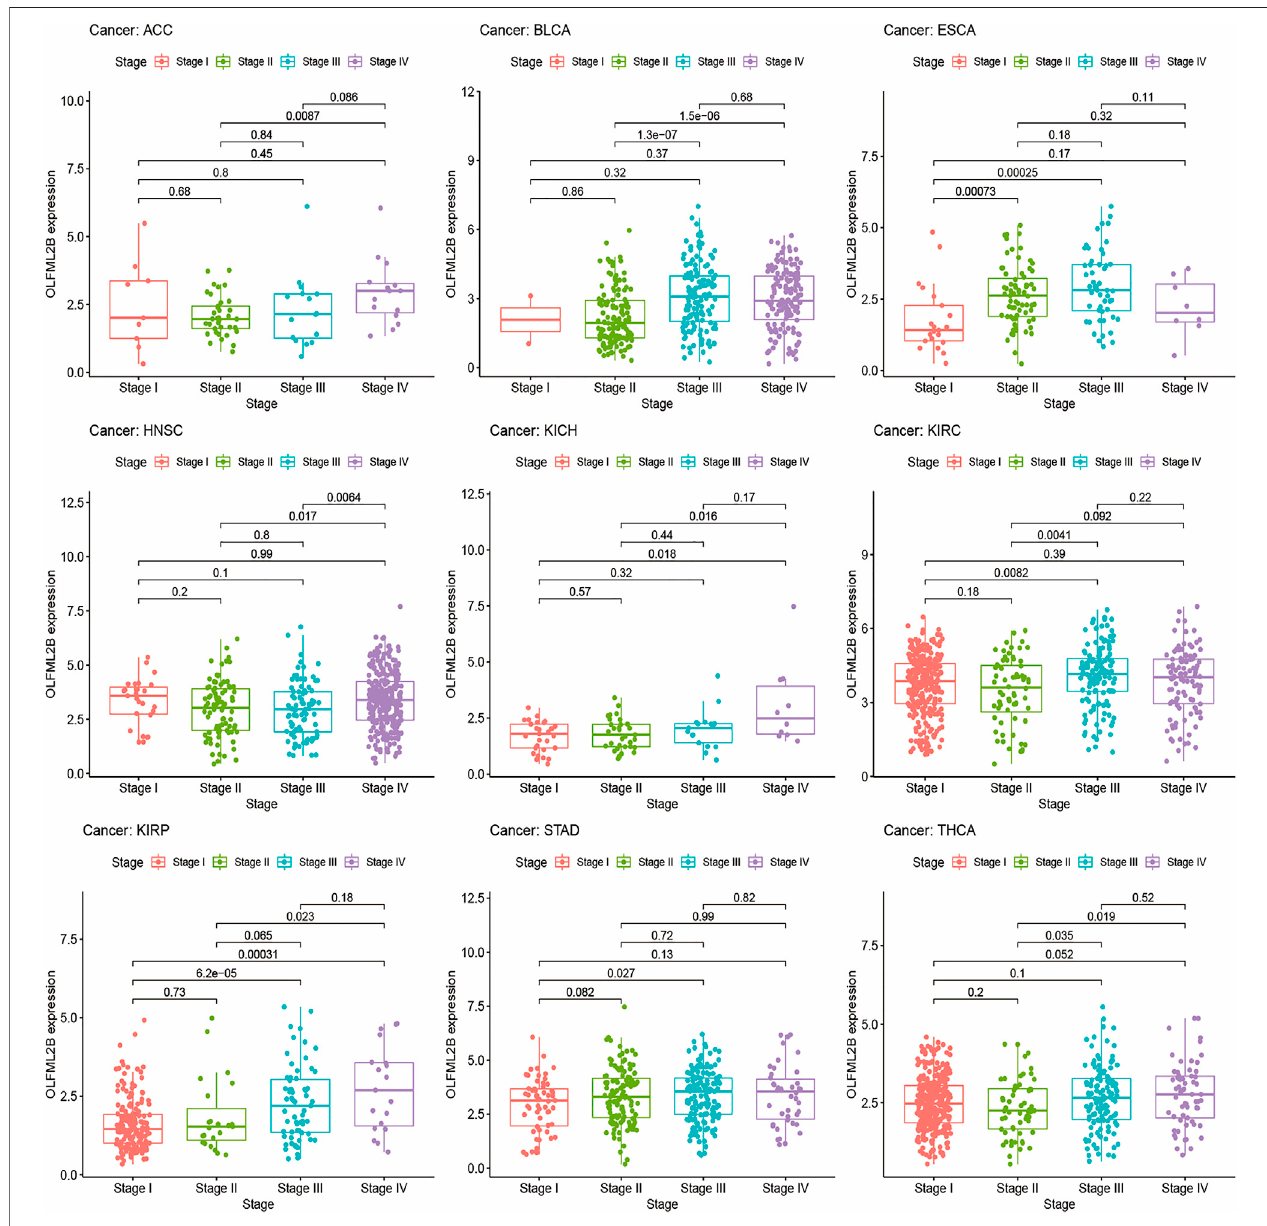
FIGURE 4 | Correlation between the expression level of OLFML2B and cancer